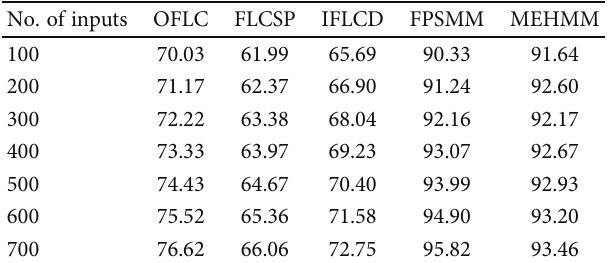
Table 4: Performance of solar photovoltaic cells.